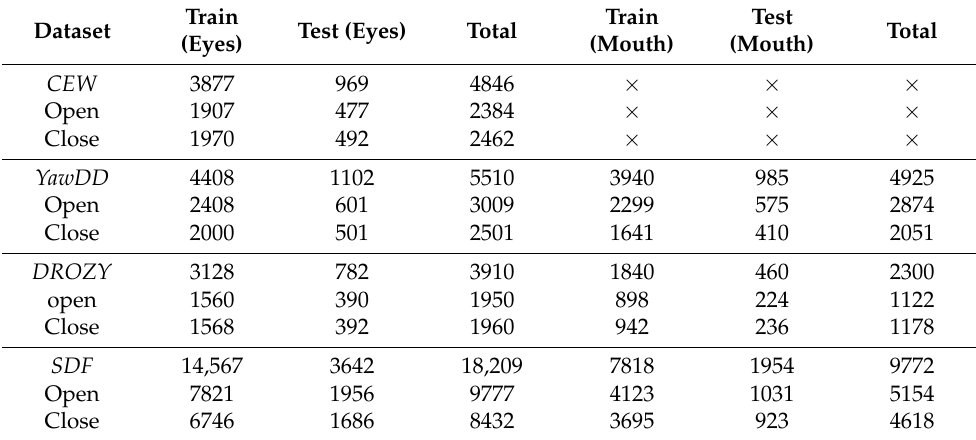
Table 2. All datasets used in this study.